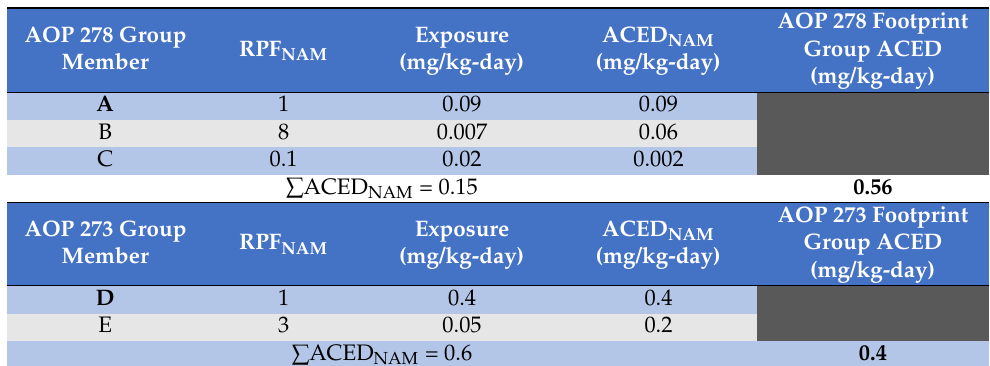
Table 3. Calculation of RPFs, ACED NAM s, and AOP footprint-specific ACEDs for a hypotheti- cal mixture of components A–E. RPF NAM = Data-driven anchor chemical BMD 1SDAED for AOP footprint/data-driven BMD 1SDAED for components in AOP footprint group; ACED NAM = RPF NAM × AOP footprint member exposure; ∑ ACED NAM = sum of group member ACED NAM s; AOP foot- print group ACED = ∑ ACED NAM × apical effect (e.g., liver injury) BMD 10HED for the AOP anchor chemical/data-driven anchor chemical BMD 1SDAED for AOP